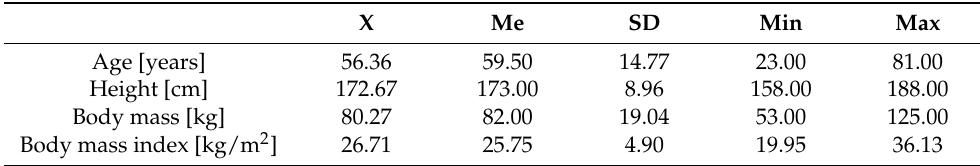
Table 1. Clinical characteristics of the study